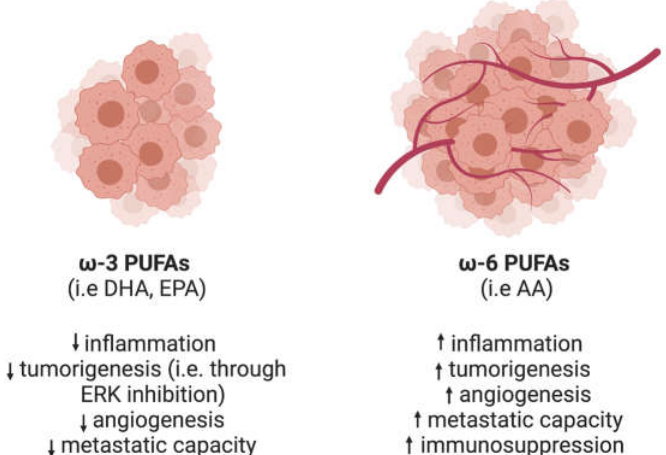
Figure 2. The effect of ω -3 and ω -6 PUFAs on tumor progression. ω -3 PUFAs, such as DHA or EPA, can exert an anti-tumor effect. Increased dietary uptake of these lipids has been linked to decreased inflammatory status and tumorigenesis. This is achieved through inhibition of pro-proliferative mechanisms, including the ERK pathway, inhibition of angiogenesis and decrease of the metastatic capacity. Conversely, these pathways are boosted by a diet rich in ω-6 PUFAs, such as arachidonic acid (AA).